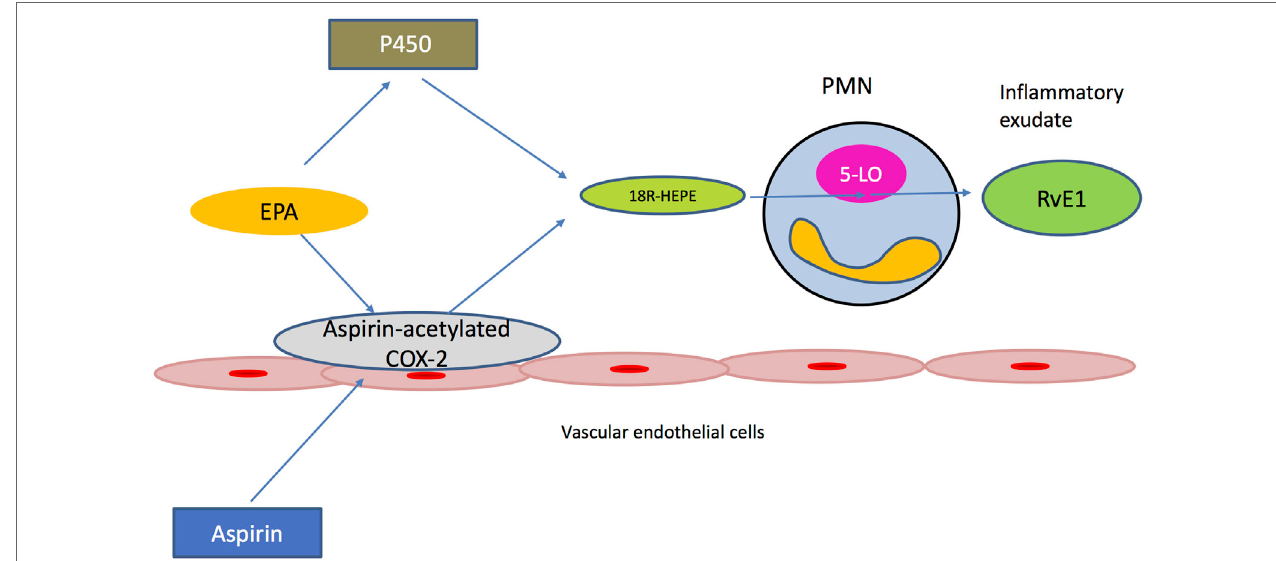
FigURe 1 | Transcellular biosynthesis of Resolvin E1 (RvE1). Edema formation delivers eicosapentaenoic acid (EPA) to the inflamed tissue. Aspirin acetylates cyclooxygenase 2 (COX2), which is present in vascular endothelial cells. The ASA-acetylated form of COX2 is still active and converts EPA to 18R-HEPE, which is then released from the endothelium. Activated polymorphonuclear neutrophils rapidly convert 18R-HEPE to Resolvin E1 (RvE1) via the action of 5-lipoxygenase (5-LO). Cytochrome P450, present in different microbes, can alternatively mediate the generation of 18R-HEPE, which will be converted to RvE1 by the host’s